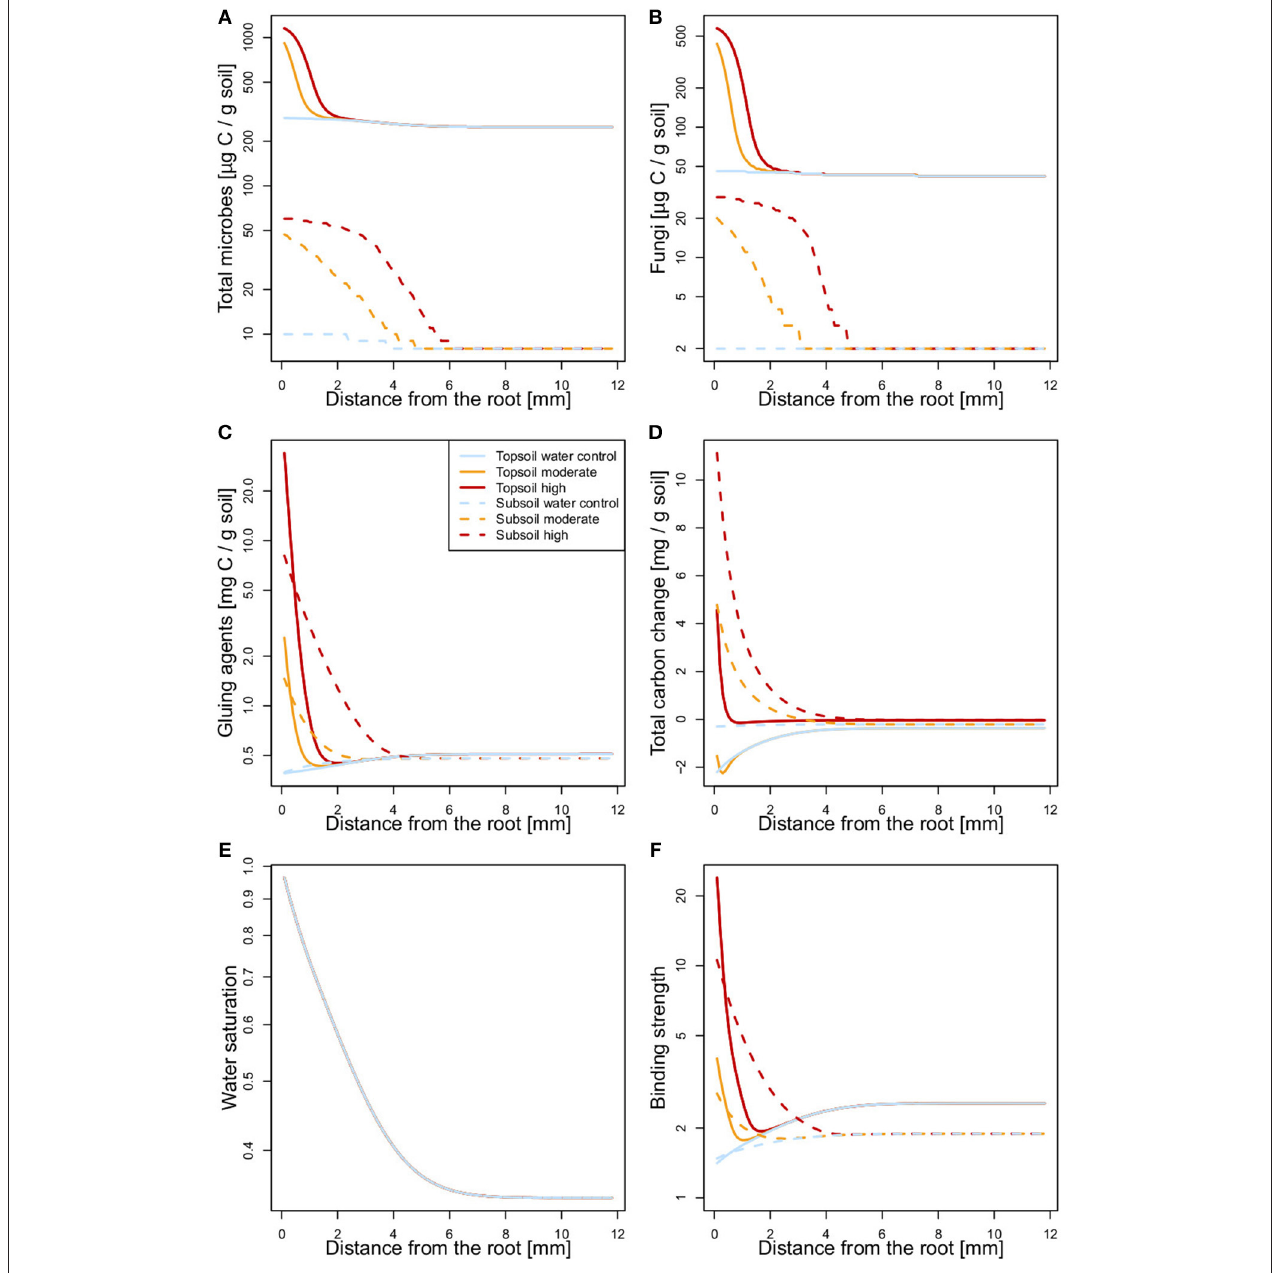
FIGURE 7 | State variables [ (A) total microbial biomass, (B) fungal biomass, (C) concentration of gluing agents, (D) change in total OC, (E) water saturation], and (F) binding strength as functions of distance from the artificial root at the end of incubation. For total carbon change in case of the high exudate addition treatment the scale is multiplied by a factor of